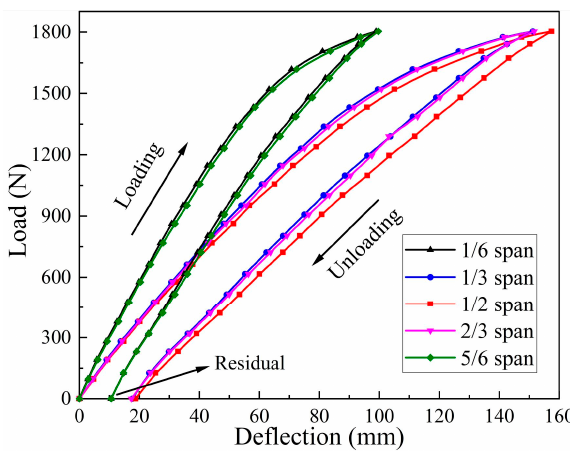
Figure 9. Load–deflection curves for the inflated sample with 30 kPa internal pressure.